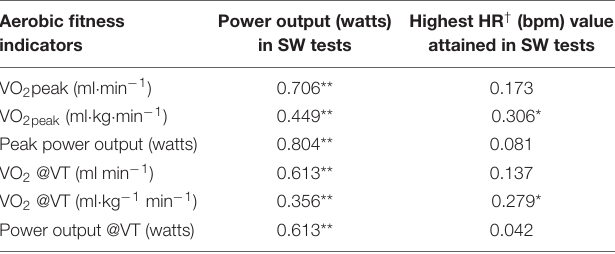
TABLE 2 | Correlation between aerobic fitness (obtained in ramp-like tests) and second wind (SW) variables. Aerobic fitness indicators